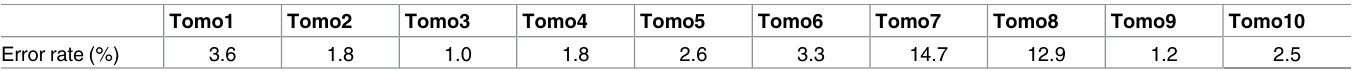
Table 2. Error rate of zebrafish tomograms.